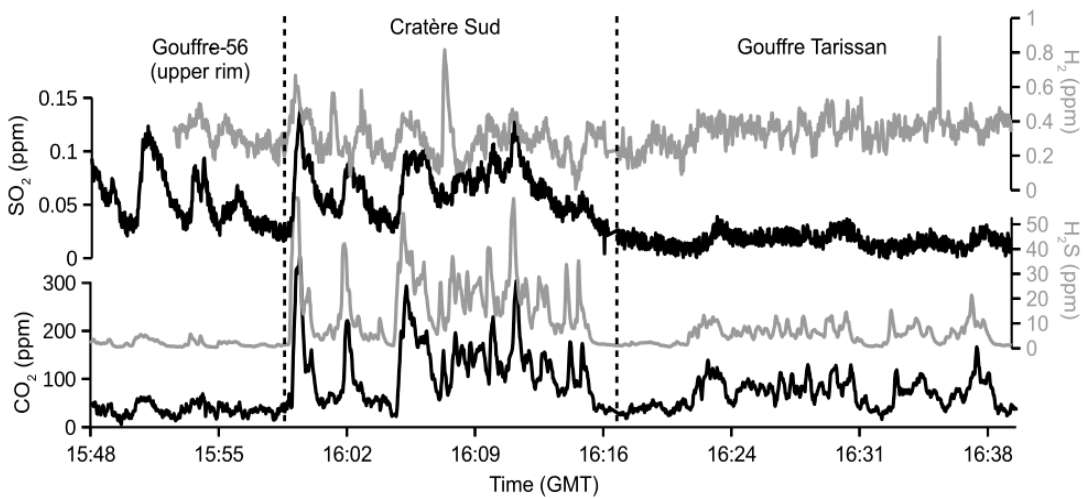
Figure 3. Example of MultiGAS recording of CO 2 , SO 2 , H 2 S and H 2 co-variations in gas emissions from Gouffre-56 (G56), Cratère Sud (CS) and Gouffre Tarissan (TAS) fumaroles during walking profiles across the plumes in May 2016.